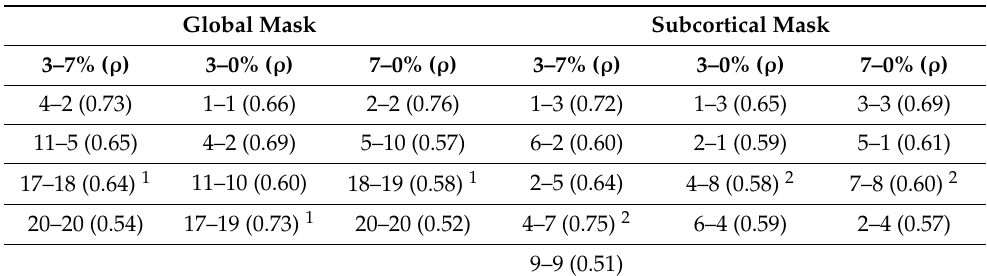
Table 1. Couples of components extracted from two different tasks exhibiting spatial Pearson correlation above